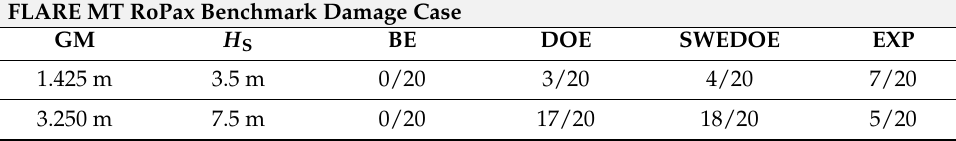
Table 3. Computed survival rates in comparison with experimental